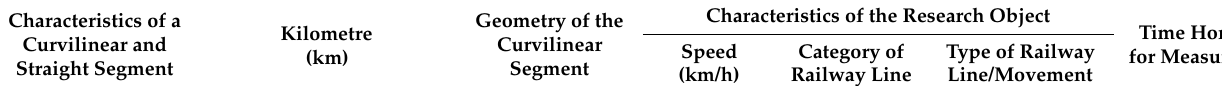
Table 1. Characteristics of the real and research